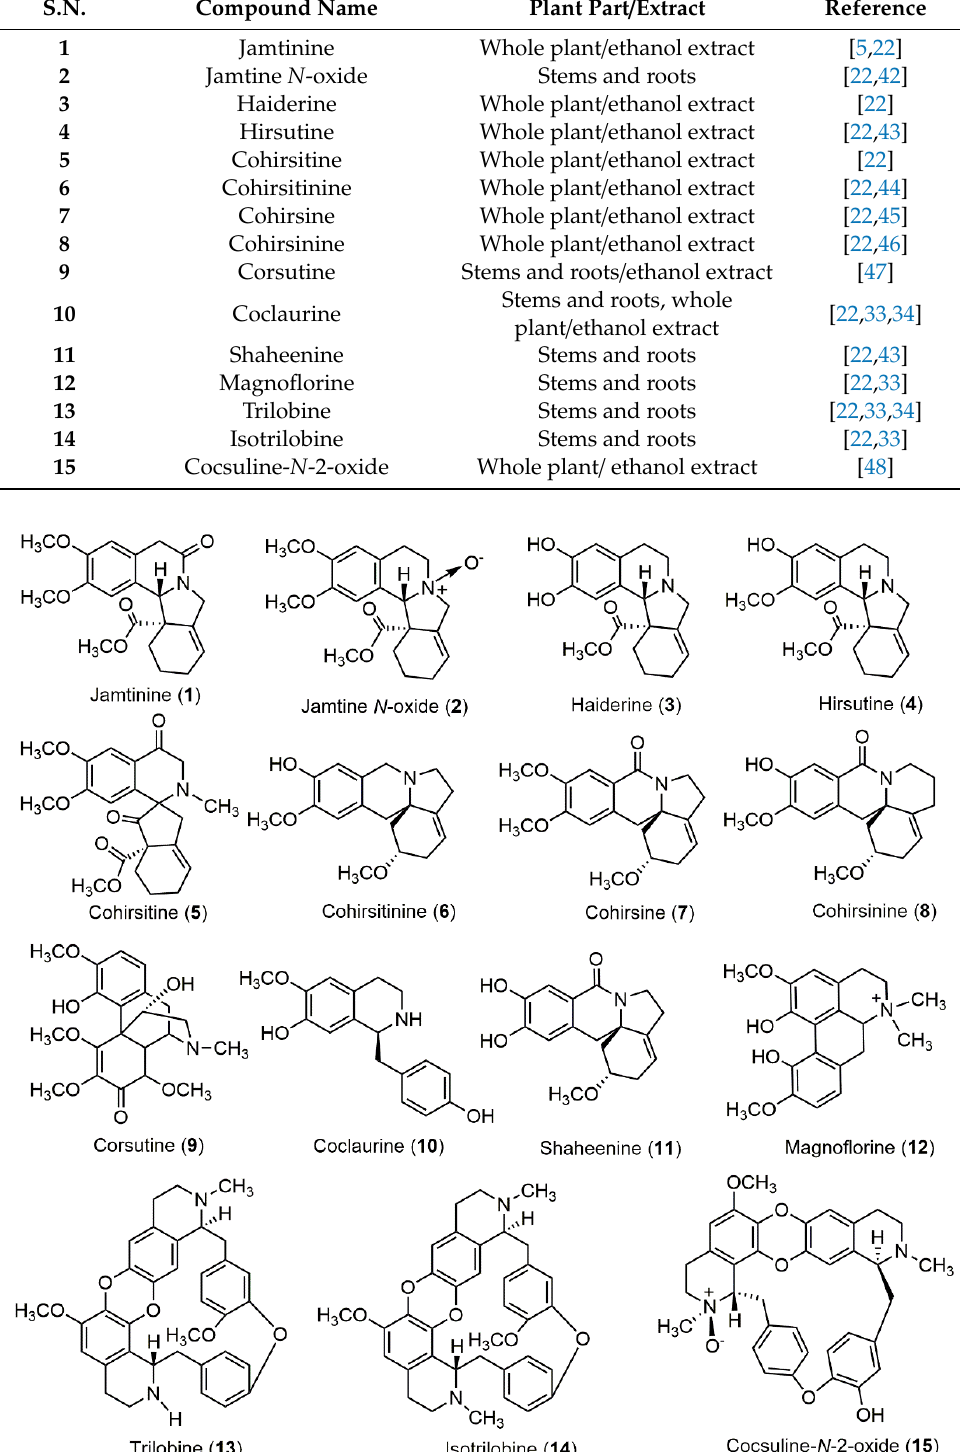
Table 1. List of reported alkaloids from form C. hirsutus.